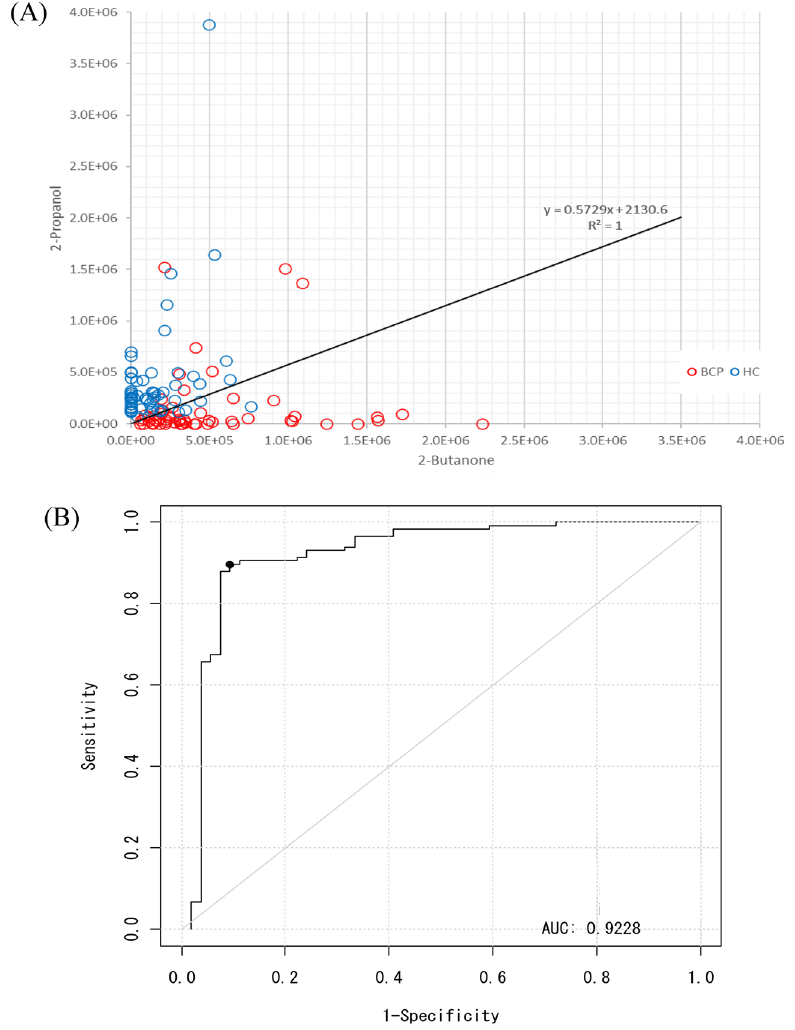
Figure 5. Scatter plots of the samples and the area under the curve (AUC) in the external validation sets. ( A ) The external validation set was used to confirm the validity of the training models. ( B ) The area under the curve using the external validation set. The AUC, sensitivity, and specificity for this model were 0.9228, 84.0%, and 90.6%, respectively.